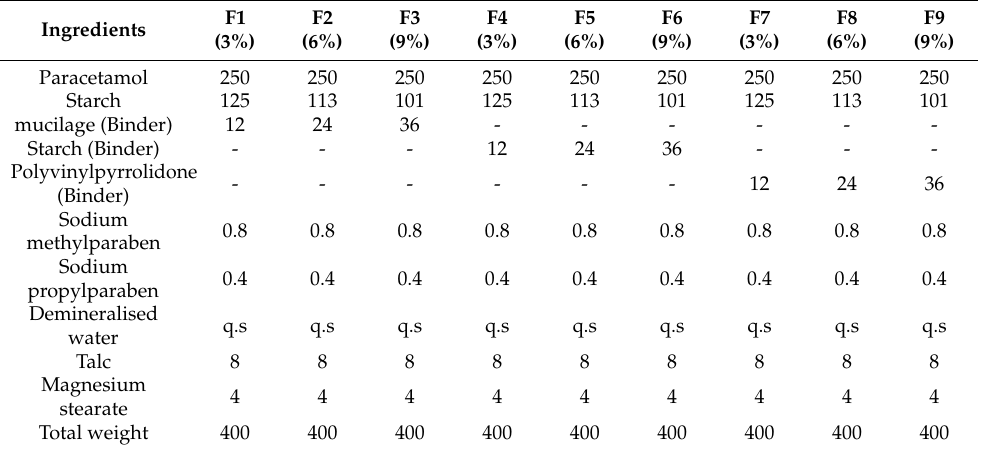
Table 1. Composition of paracetamol tablet formulation using the different binding agents of Coccinia Grandis mucilage, Starch and